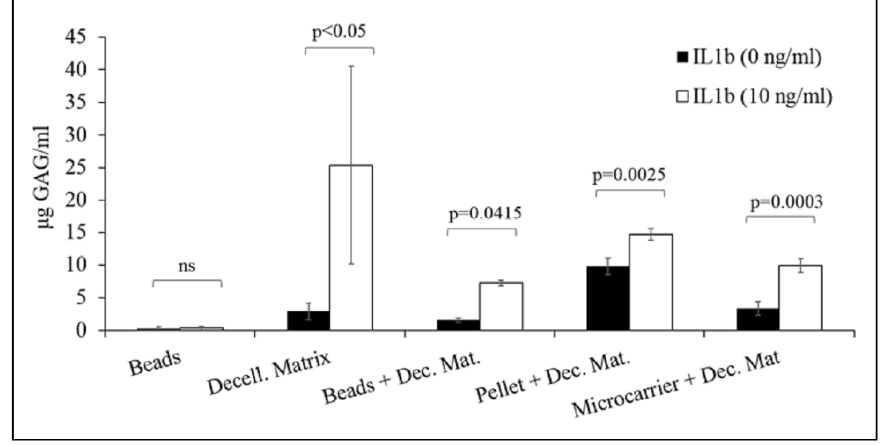
Figure 5. Mean values and standard deviation of µ g GAG/mL released by NCs before and after the treatment with IL-1 β , for each 3D